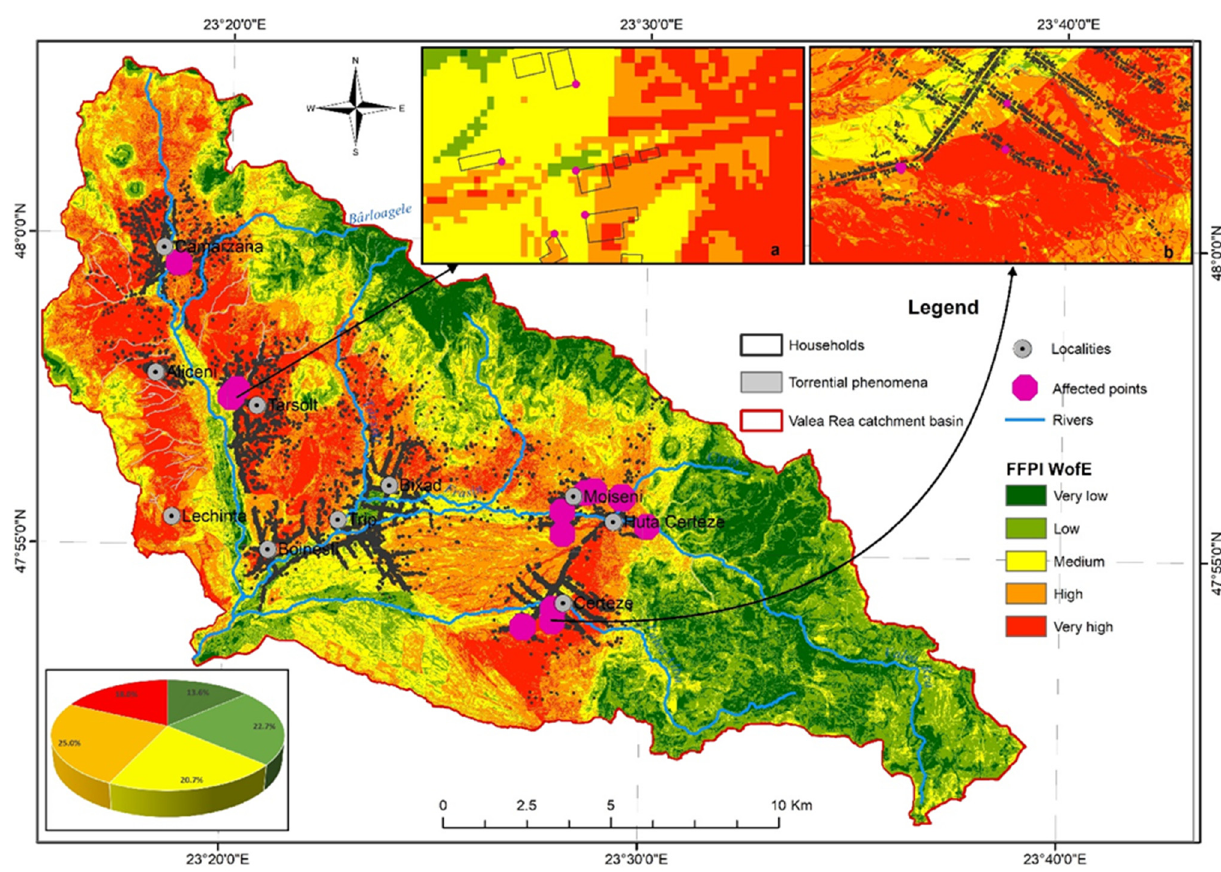
Figure 7. FFPI WofE distribution in the Valea Rea River catchment, ( a ) validation area 1, ( b ) validation area 2.